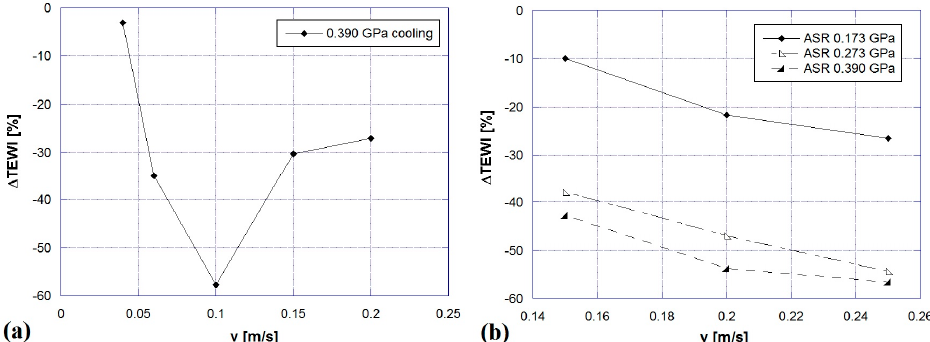
Figure 5. ∆ TEWI percentage vs. fluid flow rate for: ( a ) cooling mode; ( b ) heat pumping mode, when the system works with base fluids as HTF.